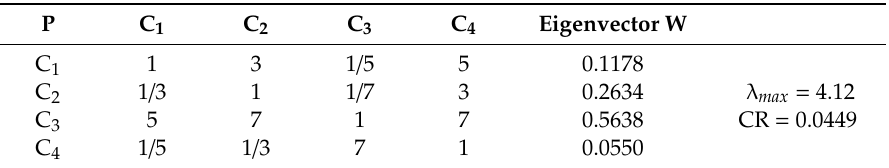
Table 7. P-C judgement matrix.